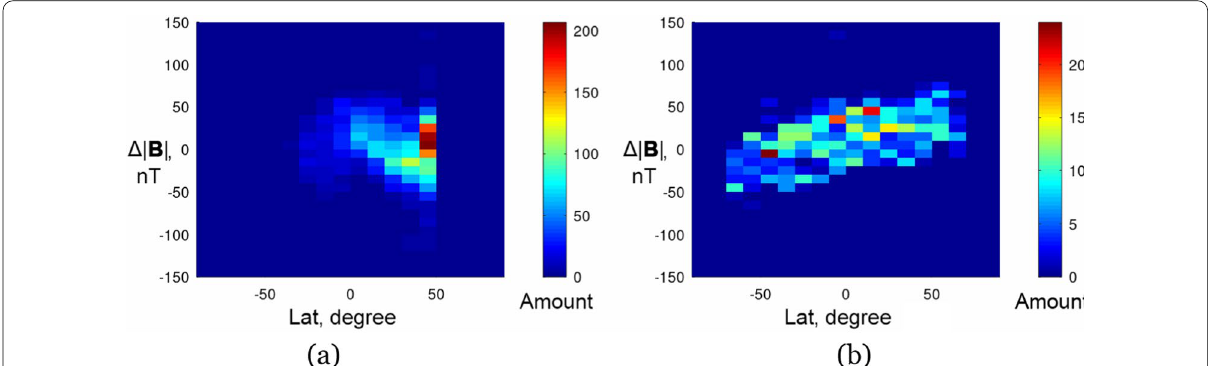
Fig. 3 Distribution of residuals along the latitude for the selected measurements from the Kosmos-49 ( a ) and Kosmos-321 ( b ) satellites. Horizontal axis shows the geographic latitude, vertical axis shows the difference between the total intensities derived from the IGRF model and measured directly by the satellite. Color scale denotes the number of